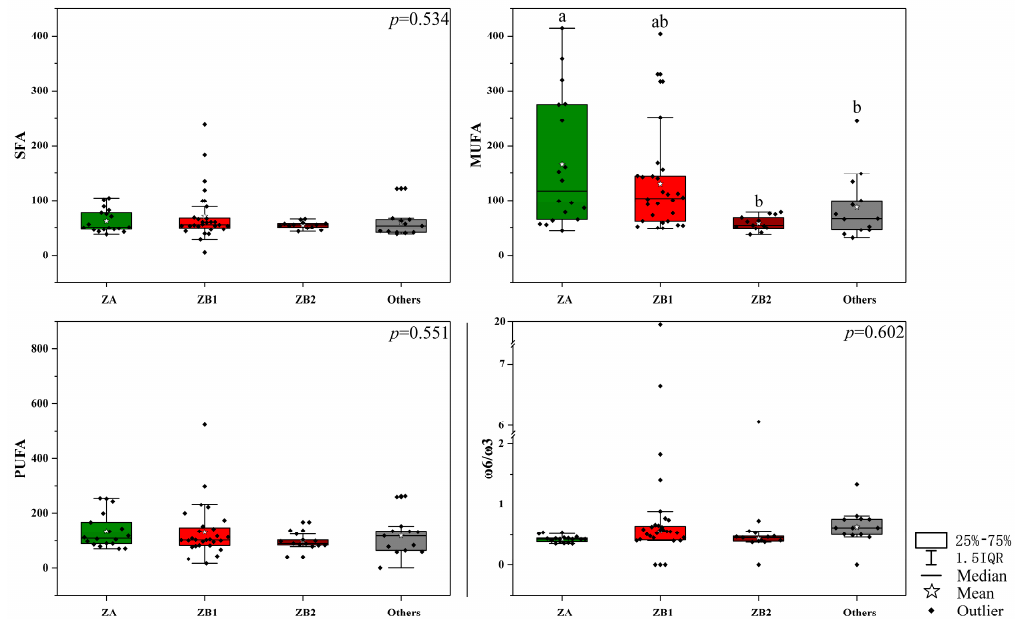
Figure 2. The total saturated fatty acid, monounsaturated fatty acid, polyunsaturated fatty acid content, and ω 6 / ω 3 value in pericarps among di ff erent Zanthoxylum groups. The di ff erent letters (a, b, or ab) above the histogram indicate significant di ff erences among the Zanthoxylum species, and no letters above the histogram means no significant di ff erence among di ff erent Zanthoxylum species ( p < 0.01); ZA is Z. armatum ; ZB1 samples, belonging to Z. bungeanum , are represented by pericarps from Hancheng; ZB2 samples, belonging to Z. bungeanum , are represented by pericarps from Fengxian; Others refers to the rest of the samples whose pericarps are red but do not belong to Z. bungeanum ; SFA is saturated fatty acid; MUFA is monounsaturated fatty acid; PUFA is polyunsaturated fatty acid; and IQR is interquartile range.